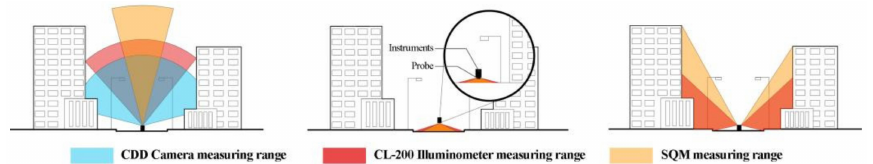
Figure 6. Types of observation instruments used in each